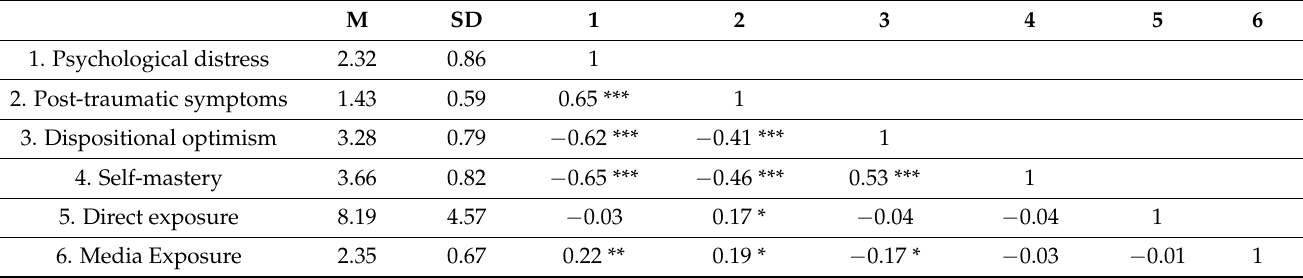
Table 1. The means, standard deviations, and bivariate correlations of the study variables (N = 161). M SD